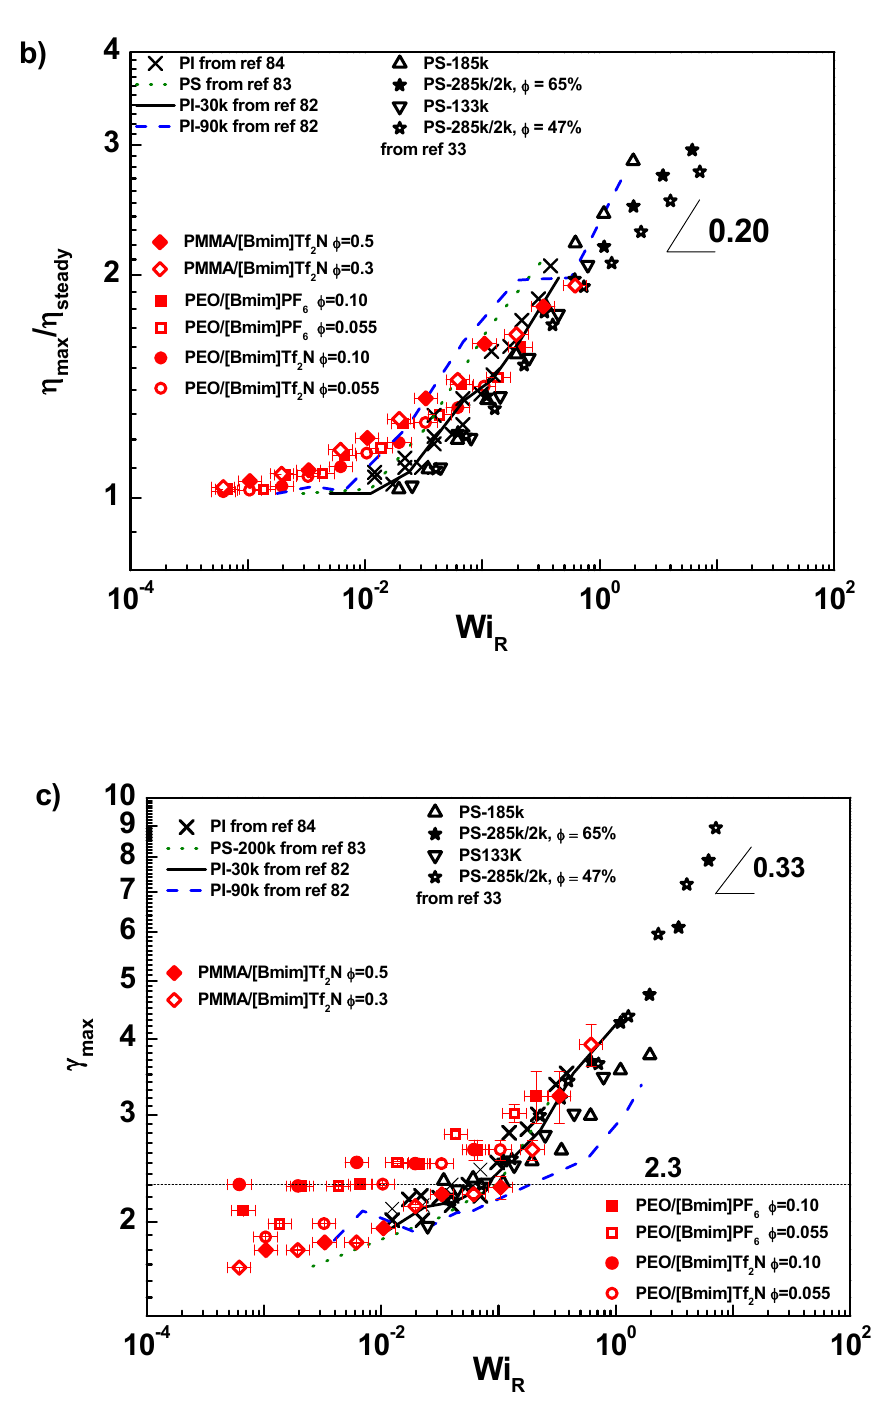
Figure 4. ( a ) Steady shear viscosities of PEO/IL solutions as a function of shear rate. The solid curves are from LVE results. ( b ) The maximum viscosity divided by steady viscosity η max / η steady , as a function of Rouse Weissenberg number Wi R . ( c ) The strain where the maximum transient viscosity appears, γ max , as a function of Wi R . The legend for all panels: ( ■ ) PEO/[Bmim][PF 6 ], ϕ = 0.10, ( ● ) PEO/[Bmim][Tf 2 N], ϕ = 0.10, ( □ ) PEO/[Bmim][PF 6 ], ϕ = 0.055, ( ○ ) PEO/[Bmim][Tf 2 N], ϕ = 0.055, ( ◆ ) PMMA/[Bmim][Tf 2 N], ϕ = 0.50, ( ◇ ) PMMA/[Bmim][Tf 2 N], ϕ = 0.30, ( △ ) PS ‐ 185 kg/mol (ref [33]), ( ▽ ) PS ‐ 133 kg/mol (ref [33]), ( ★ ) PS ‐ 285 kg/mol in PS ‐ 2 kg/mol solution, ϕ = 65% (ref [33]), ( ☆ ) PS ‐ 285 kg/mol in PS ‐ 2 kg/mol solution, ϕ = 47% (ref [33]), ( ̇ ∙∙∙∙∙ ) PS ‐ 200 kg/mol (ref [83]), (—) PI ‐ 30 kg/mol (ref [82]), ( ‐‐‐‐‐ )PI ‐ 90 kg/mol (ref [82]), ( × ) PI (ref [84]).